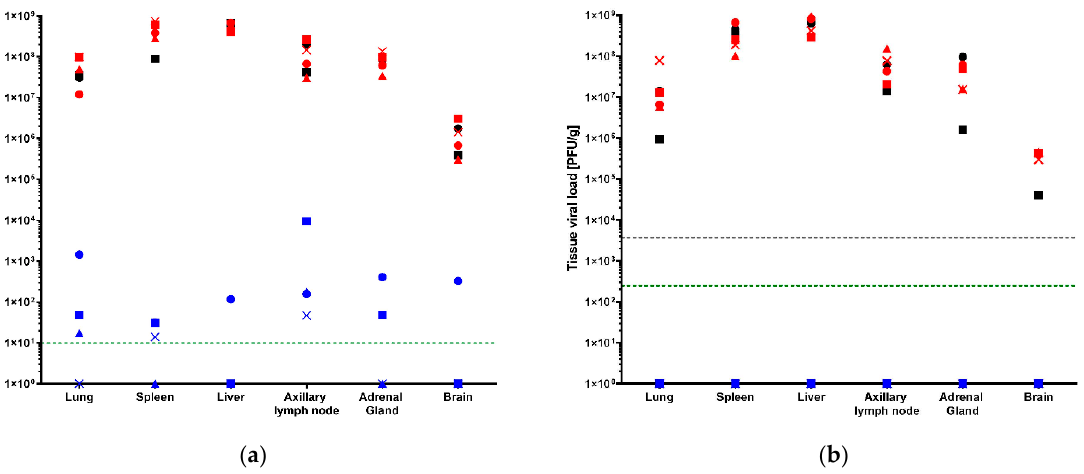
Figure 3. Post-challenge tissue viral loads. ( a ) tissues viral loads by qRT-PCR; ( b ) tissue viral loads by plaque assay. 1 × 10 11 vp animals are shown in blue. 1 × 10 6 vp animals are shown in red. Saline control animals are shown in black. NHP1 of each group is shown as a circle, NHP2 is shown as a square, NHP3 is shown as a triangle and NHP4 is shown as an “ × ”. LOD is shown as a green dashed line, and the LLOQ is shown as a gray dashed line. In cases where the LOD is also the LLOQ, a single green dashed line is